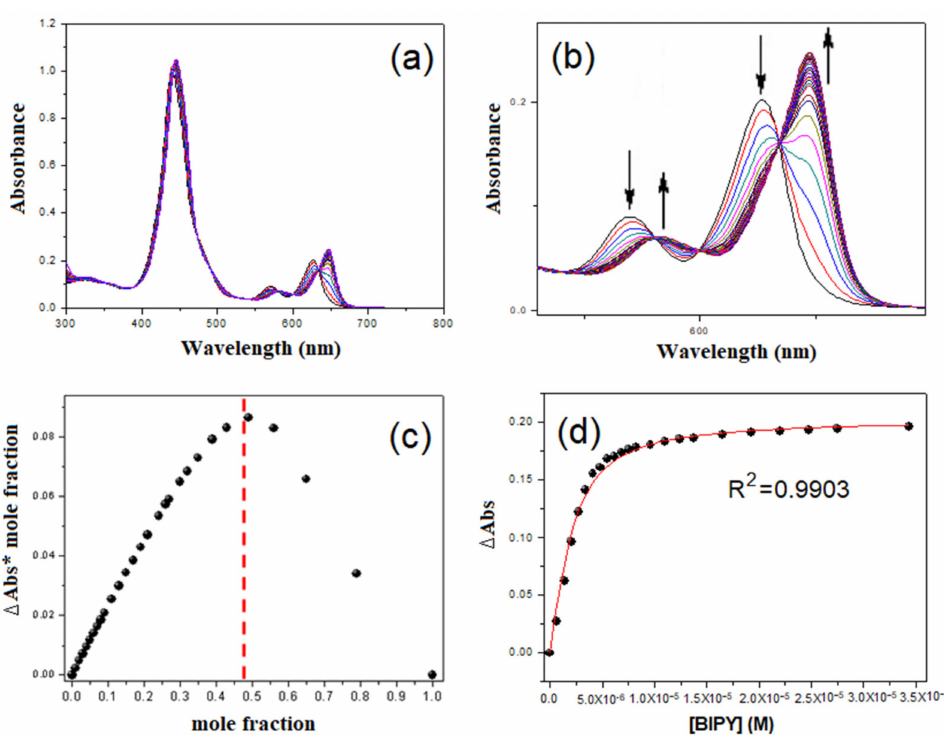
Figure 2. UV-vis titration spectra of Zn-trisporphyrin 1 with BIPY in toluene ( c = 1 µ M). ( a ) UV-vis region, ( b ) Q-band zone, ( c ) data curve for Job’s plot at 446 nm (mole fraction of 1 ), ( d ) fitting curve for the determination of the binding constant K 32 at 446